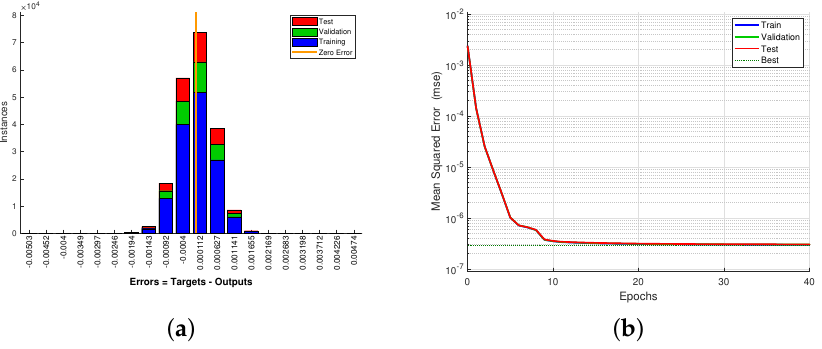
Figure 6. Results of the training process. ( a ) Error of the neural network. ( b ) Mean squared error during the training process.